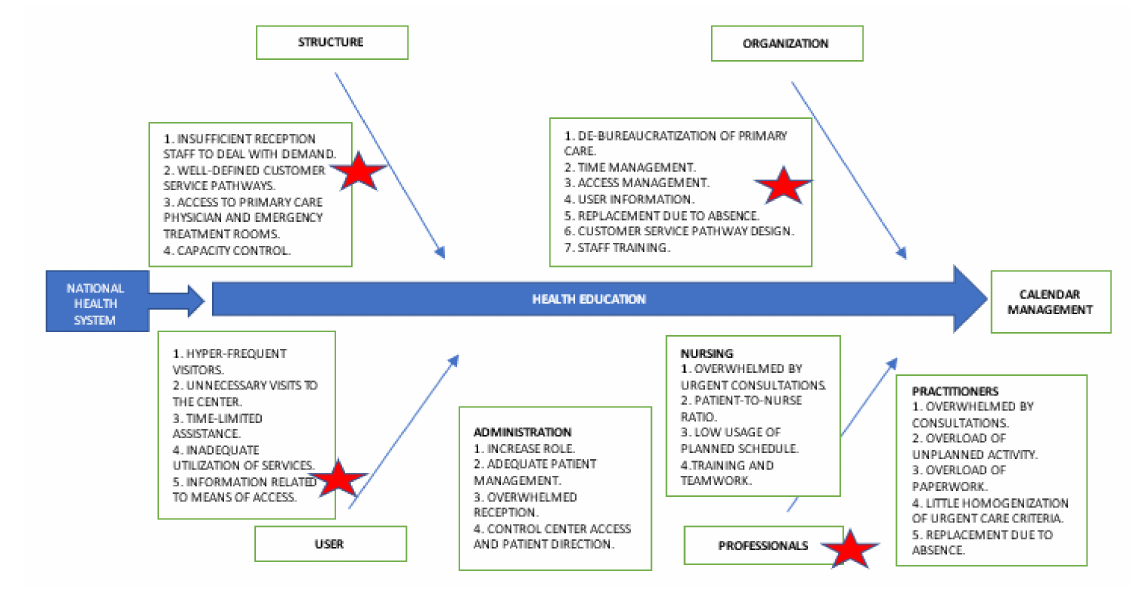
Figure 5. Ishikawa